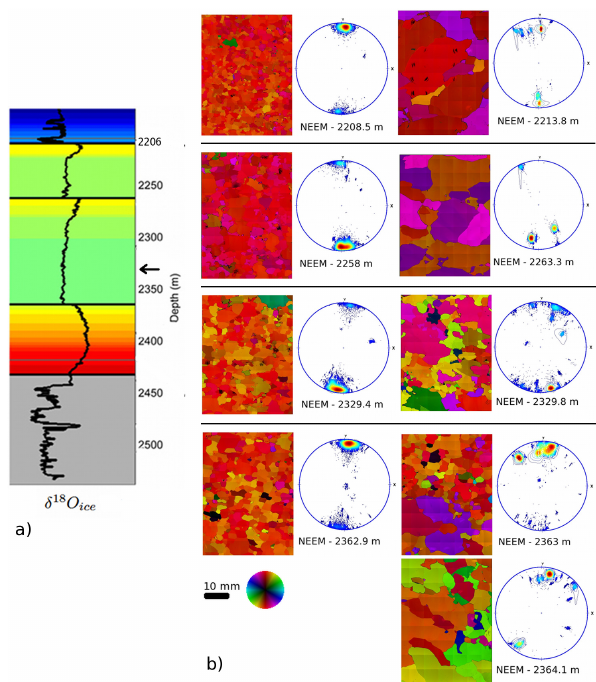
Figure 7. Abrupt variations of fabrics and microstructures around the discontinuities observed in the δ 18 O ice signal (a) (Dahl-Jensen et al., 2013). Different colors along the stable isotope record high- light the disturbed sections. The reconstructed age-scale corre- sponds to a continuous color scale. Microstructure and fabric data (b) were chosen on each side of the various discontinuities, but also to reveal other discontinuities (see text). The length scale is the same for all microstructure images (black line). The orientation color scale is given by the color wheel. The pole figures are plotted with the vertical axis (core axis) vertically in the plane of the